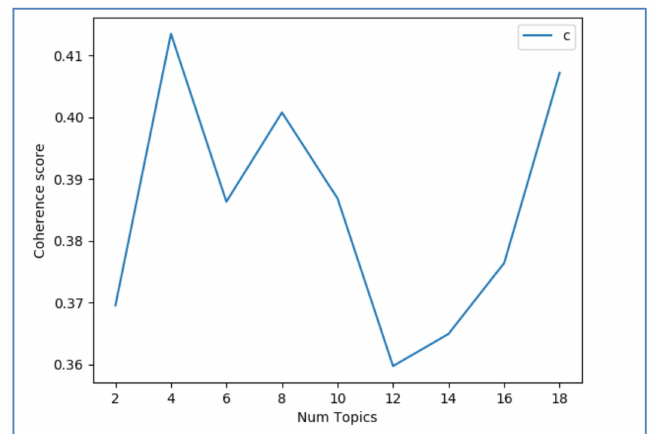
Figure 14. The optimal number of topics (Symptom